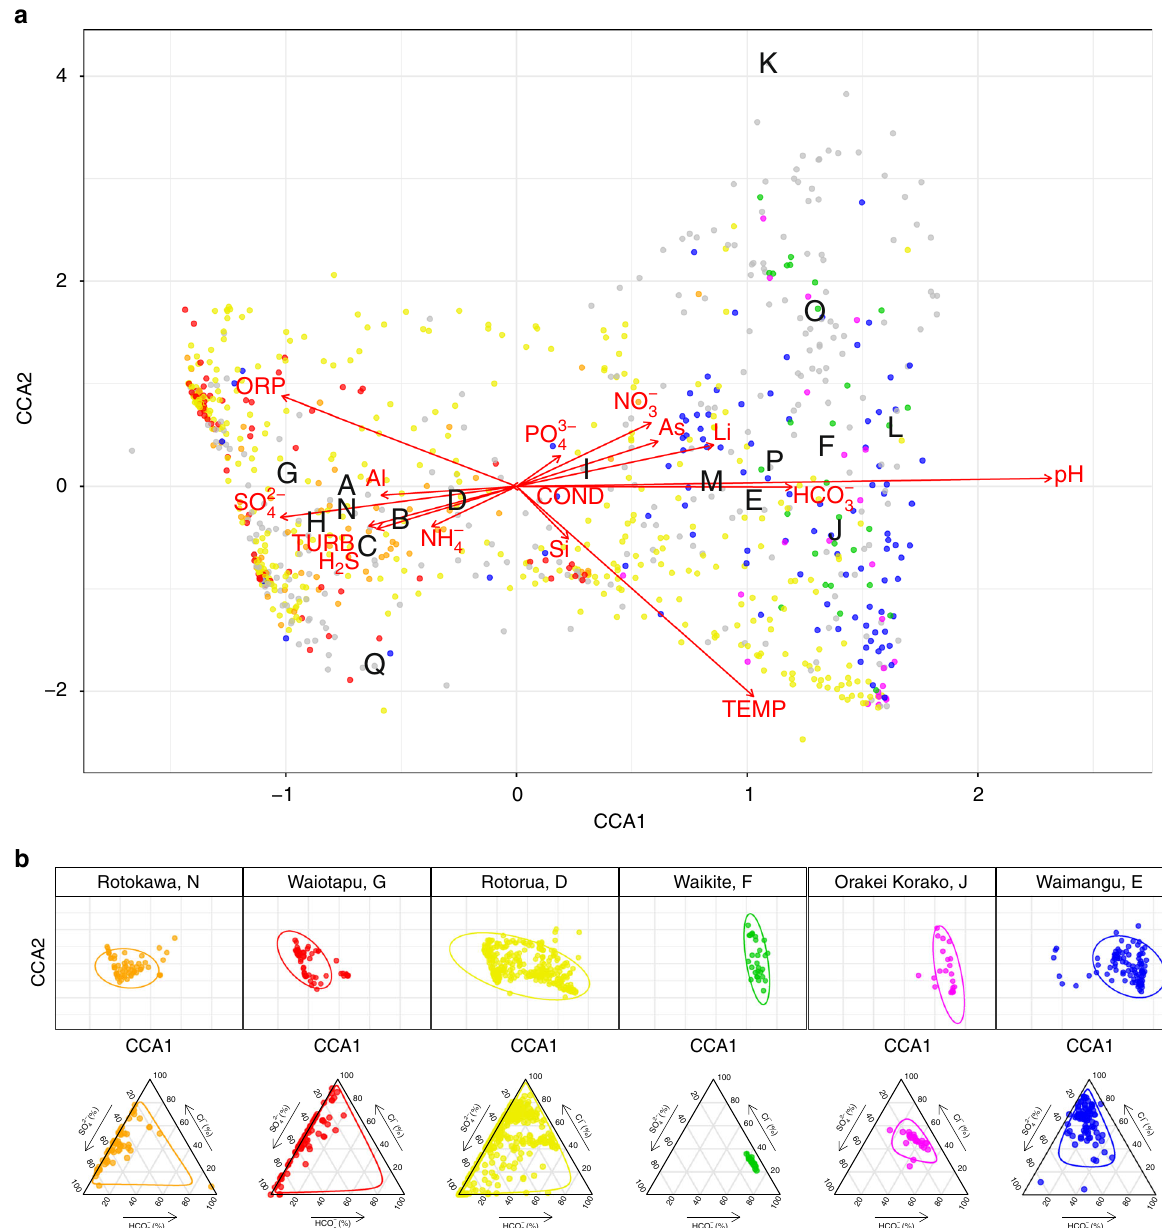
Fig. 3 Constrained correspondence analysis (CCA) of beta diversity with signi fi cant physicochemistry. a A scatter plot of spring community dissimilarities ( n = 923), with letters corresponding to centroids from the model for geothermal fi elds (A – Q; White Island, Taheke, Tikitere, Rotorua, Waimangu, Waikite, Waiotapu, Te Kopia, Reporoa, Orakei Korako, Whangairorohea, Ohaaki, Ngatamariki, Rotokawa, Wairakei-Tauhara, Tokaanu, Misc). Coloured communities are from fi elds represented in the subpanel. Constraining variables are plotted as arrows (COND: conductivity, TURB: turbidity), with length and direction indicating scale and area of in fl uence each variable had on the model. b The top panel represents a subset of the full CCA model, with select geothermal fi elds shown in colour (including 95% con fi dence intervals). The bottom panel shows their respective geochemical signatures as a ratio of chloride (Cl − ), sulfate SO 2 (cid:1) 4